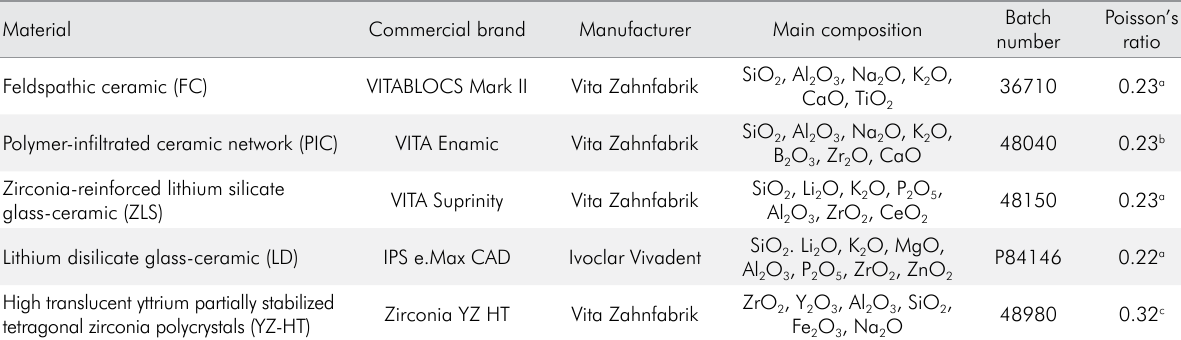
Table 1. Materials used in this